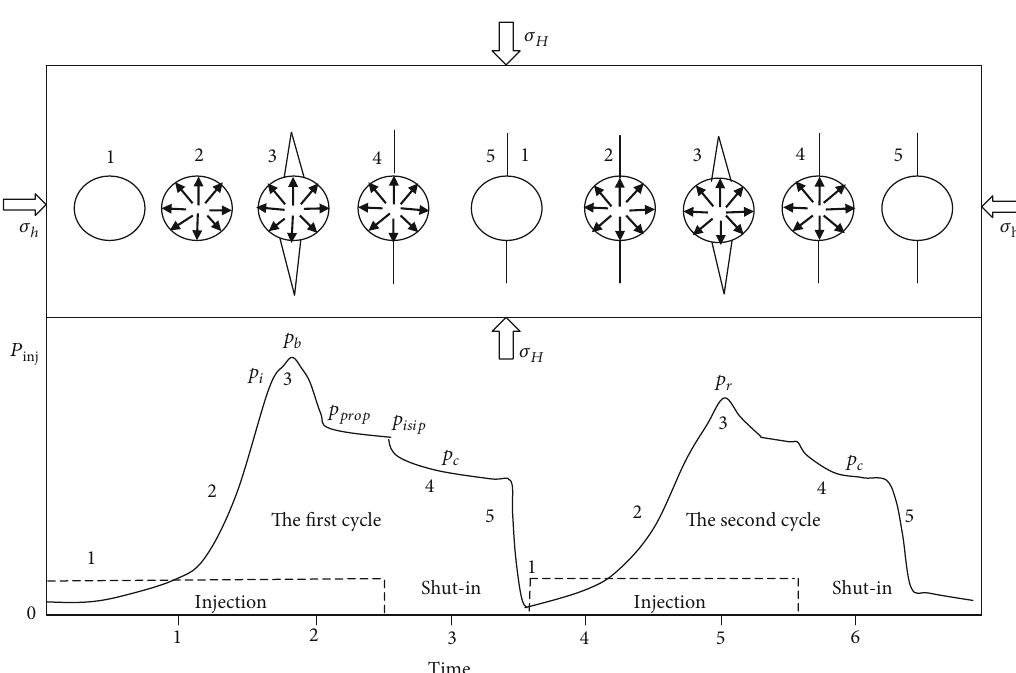
Figure 6: Schematic plot of a typical XLOT of two injection cycles. Upper fi gure: schematic borehole tensile failure stages (fracture growth and closure) versus the injection pressure; lower fi gure: the relationship of pumping pressure, fracture initiation pressure, formation breakdown pressure, and testing